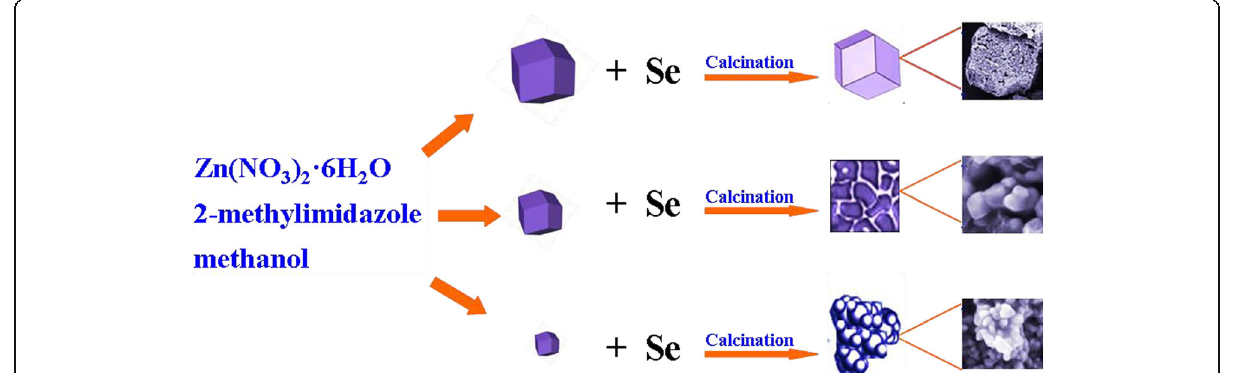
Fig. 1 Schematic illustration of the fabrication process of ZnSe/NC composites